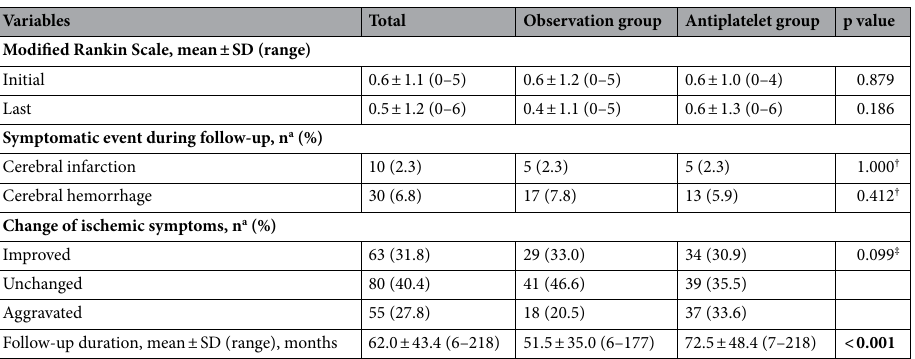
Table 2. Clinical results. p < 0.05 statistically significant (marked in bold). Unless specified otherwise, values indicate the data of patients. † Logistic regression model using GEE. ‡ Multinomial logistic regression model using GEE. a Number of